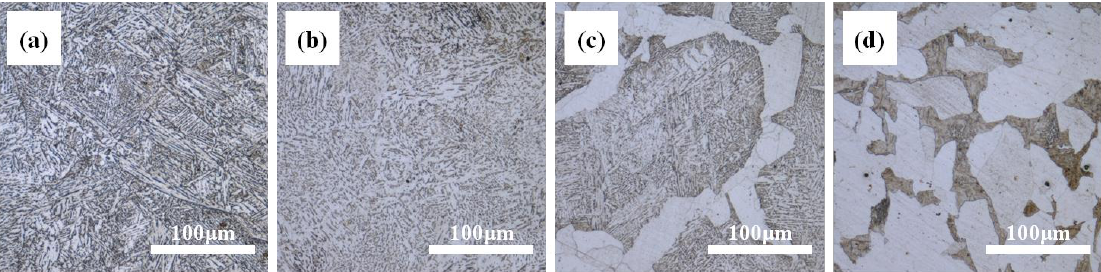
Figure 11. Microstructures of the specimens of Sb+Sn steel at different temperatures. ( a ) 1100 °C; ( b ) 850 °C; ( c ) 750 °C; ( d ) 650 °C.